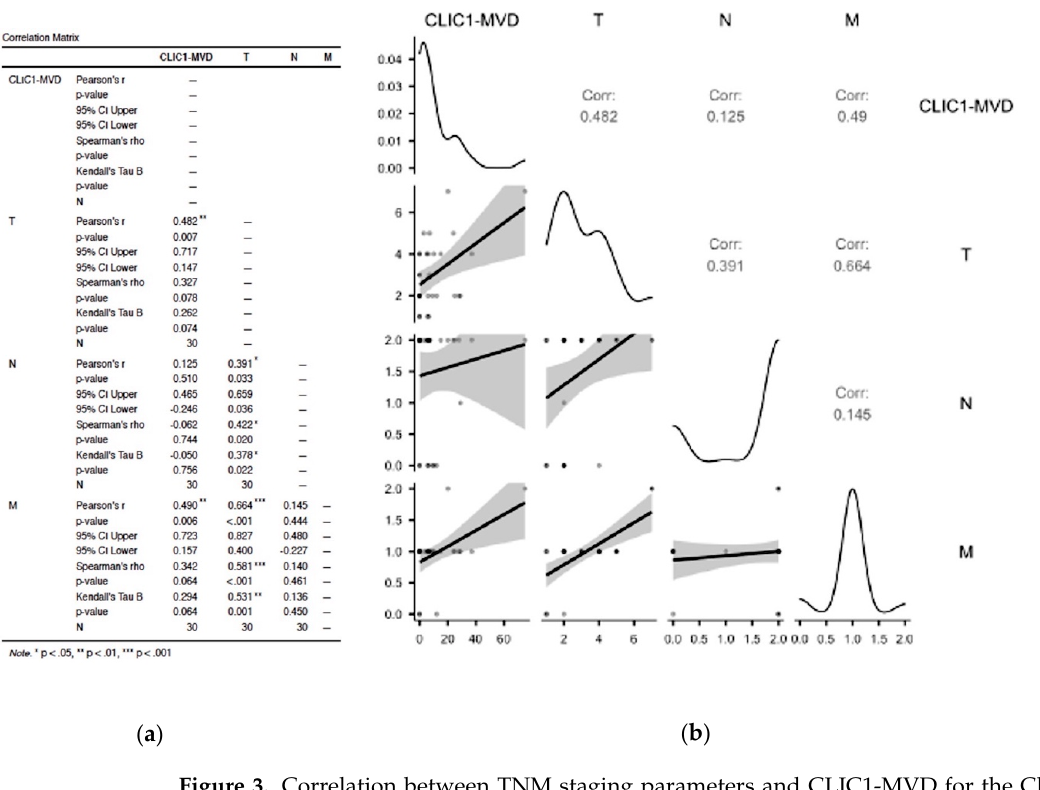
Figure 3. Correlation between TNM staging parameters and CLIC1-MVD for the Class 3 group ccRCC cases. Correlation matrix ( a ) highlighted significant correlation between CLIC1-MVD, T, and M parameters. Moreover, Class 3 is the only ccRCC subgroup where the T parameter is strongly correlated with the N and M parameter, suggesting that a high CLIC1 expression in tumor cells may favor nodal and distant metastasis. Graphical representation of the data from the correlation matrix is found in ( b ).